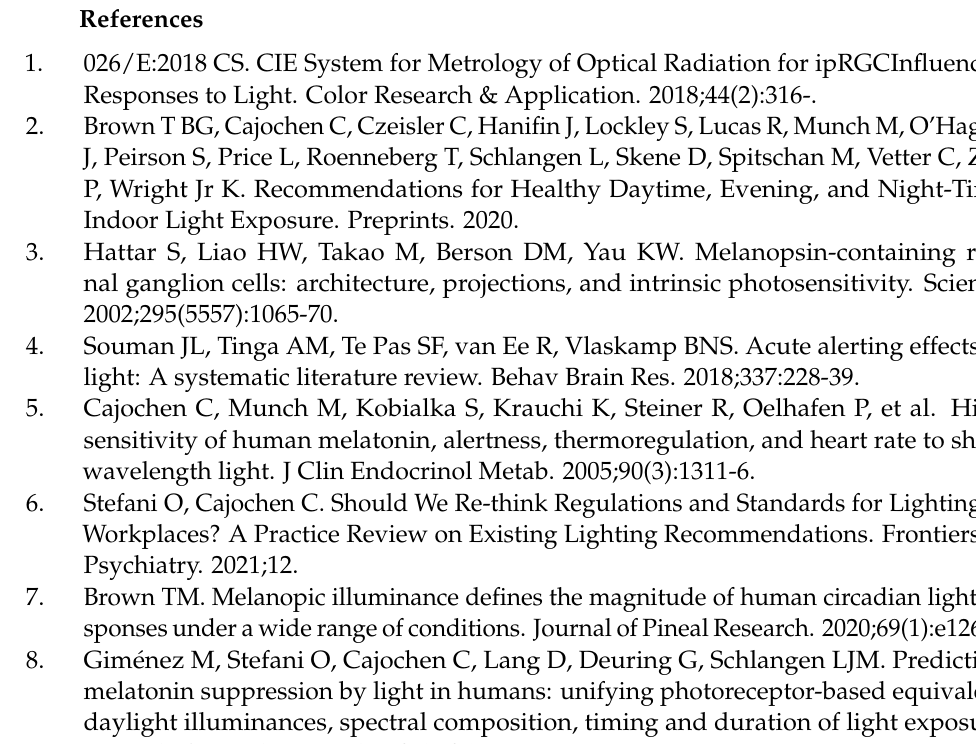
Figure 3. ( A – C ): Results of the